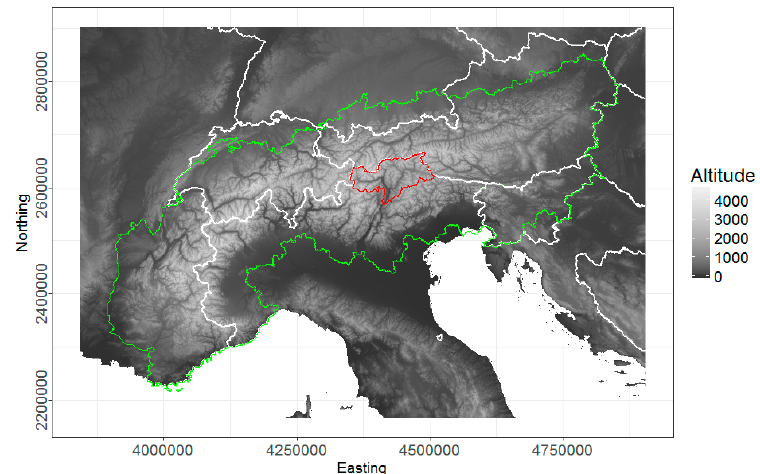
Figure 1. Overview of the study area showing the elevation with the boundary of the Alps as defined by the Alpine Convention (green), state borders (white), and the border of the province of Bolzano (South Tyrol, red).